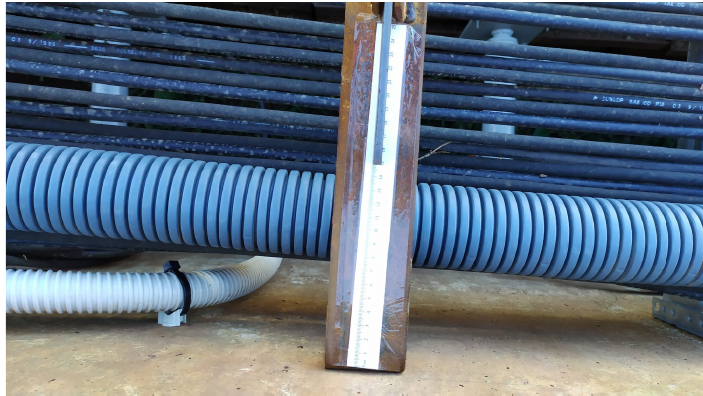
Figure 12. Zoom of the marker bar for the displacement measurement.